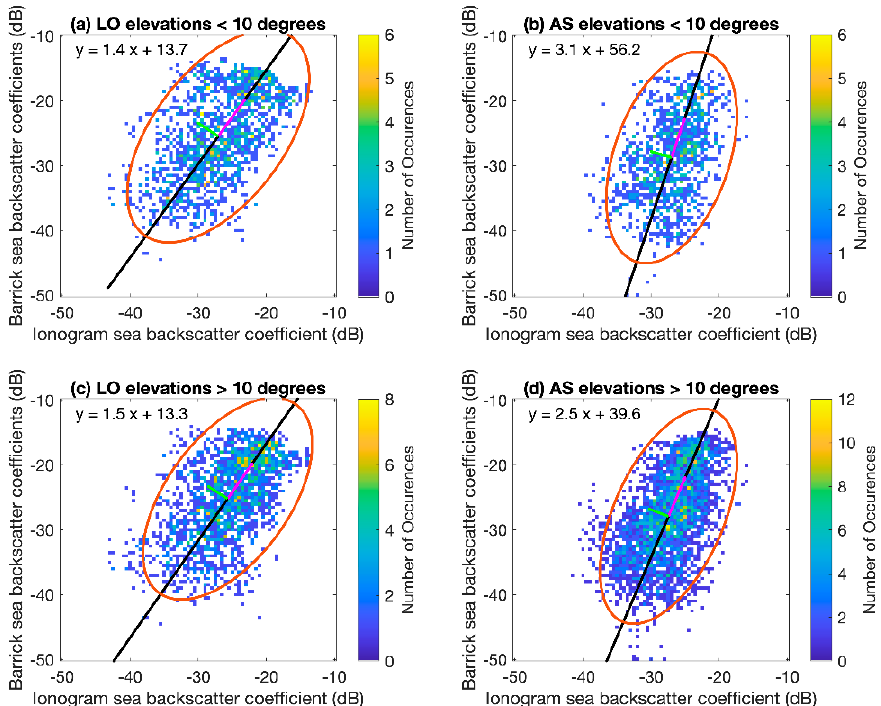
Figure 13. Scatter plots of the sea surface backscatter coefficients from the Barrick versus the ionogram method for rays with ( top ) elevations less than 10 degrees and ( bottom ) elevations greater than 10 degrees. A line of best fit is shown in black, with the corresponding equation in the top left corner and a 95% confidence error ellipse shown in red. The eigenvectors of the covariance matrix are shown in green and magenta.